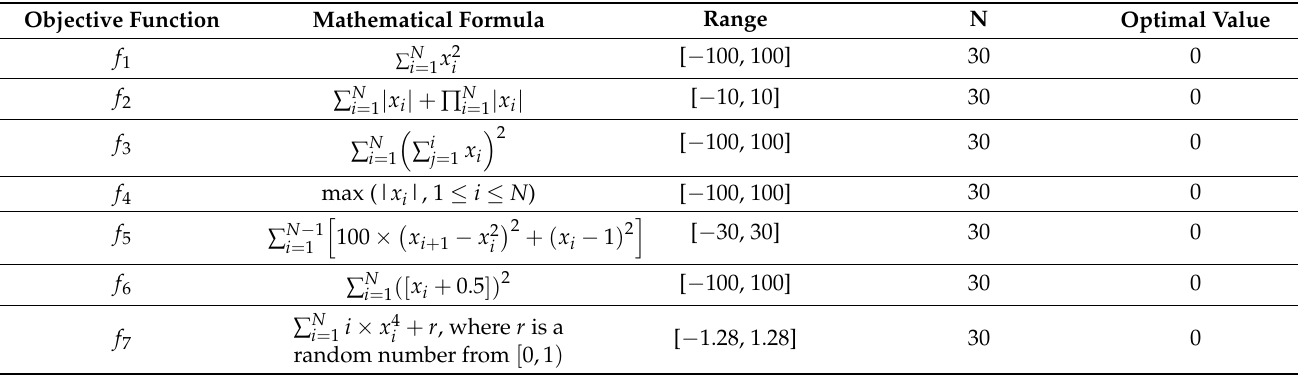
Table 2. Unimodal Objective Functions (Objective Functions f 1 − f 7 ).